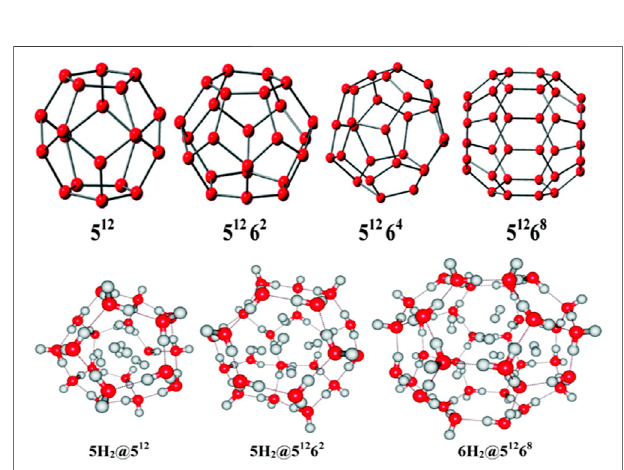
FIGURE 12 | Optimized geometries of the clathrate hydrates along with theirmaximum possibleH 2 moleculeencapsulated complexes. (Adapted with permission from Chattaraj et al., 2011. Copyright© 2011, American Chemical